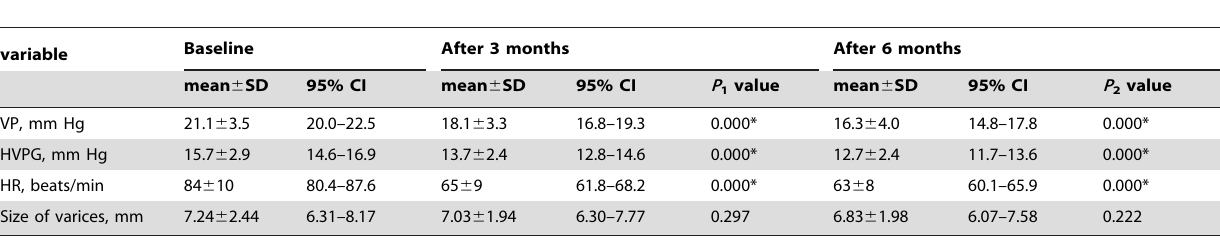
Table 2. Changes in variceal pressure, hemodynamics, endoscopic findings under propranolol administration.